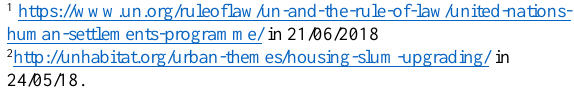
Figure 1. Favela typo-morphology. Source: Andrew Gavin Marshall. Available